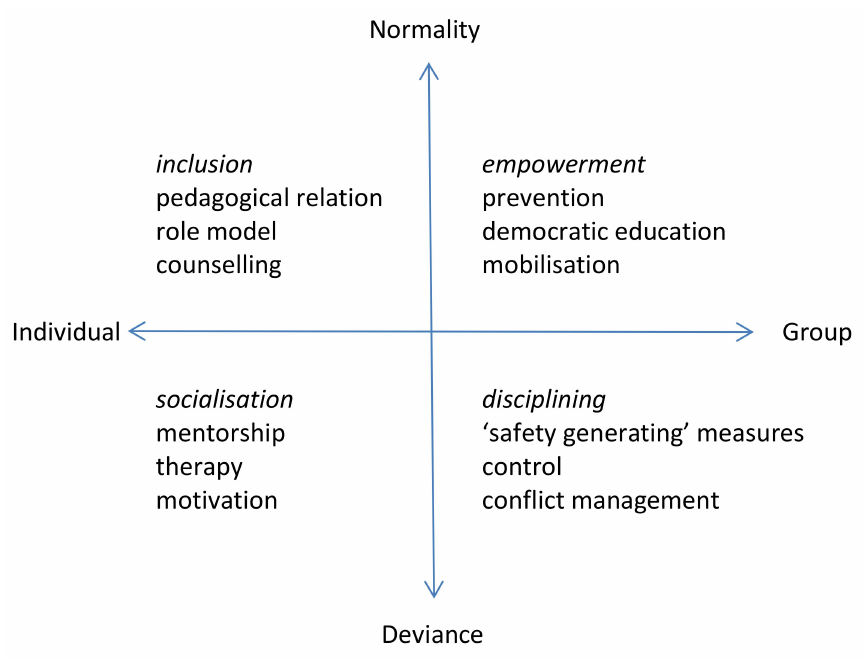
Figure 1. Social pedagogical positions with examples of